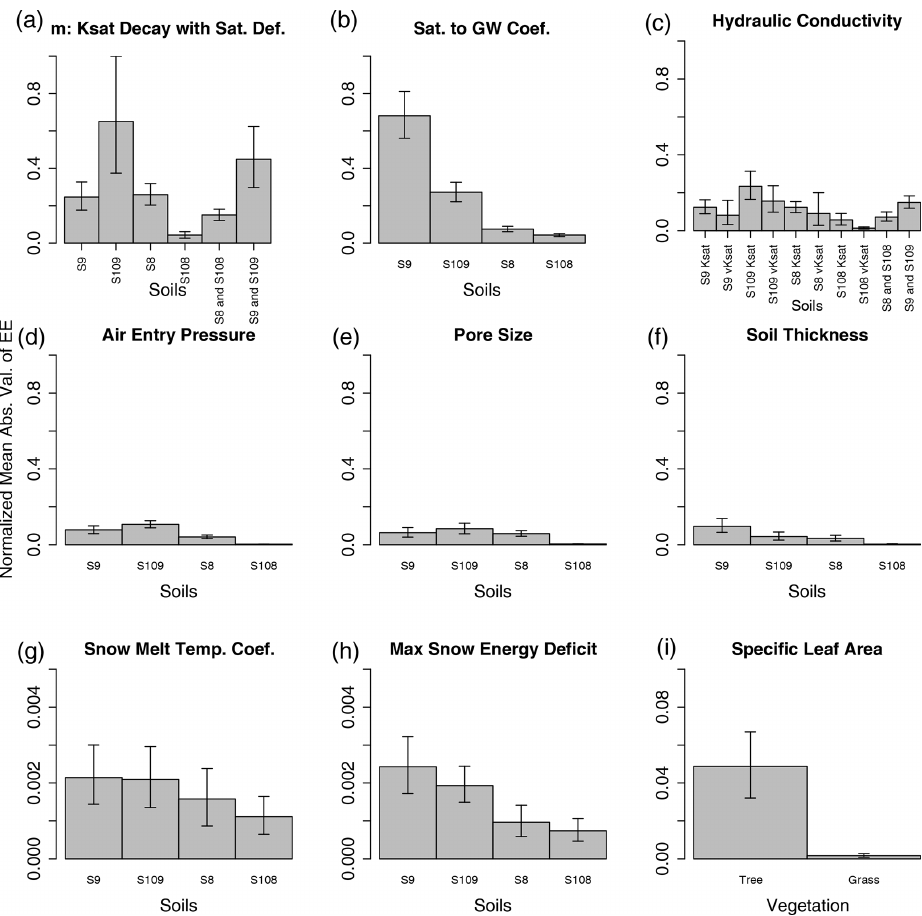
Figure 5. Barplots of the mean absolute value of the elementary effects for parameters that can be adjusted by 10 RHESSys multiplier param- eters (panel (c) contains two multipliers). Bootstrapped error bars extend from the 5th to 95th percentile estimates. The effects correspond to the 95th percentile streamflow sensitivity metric and are all normalized using the same maximum error bar value as in Fig. 3. The x axis of each plot indicates which soil or vegetation type is considered. For hydraulic conductivity, it also indicates which parameter is considered (vertical (vKsat) or lateral ( K sat ) conductivity). Note that the plots in the bottom row have different y axes ranges than each other and the plots